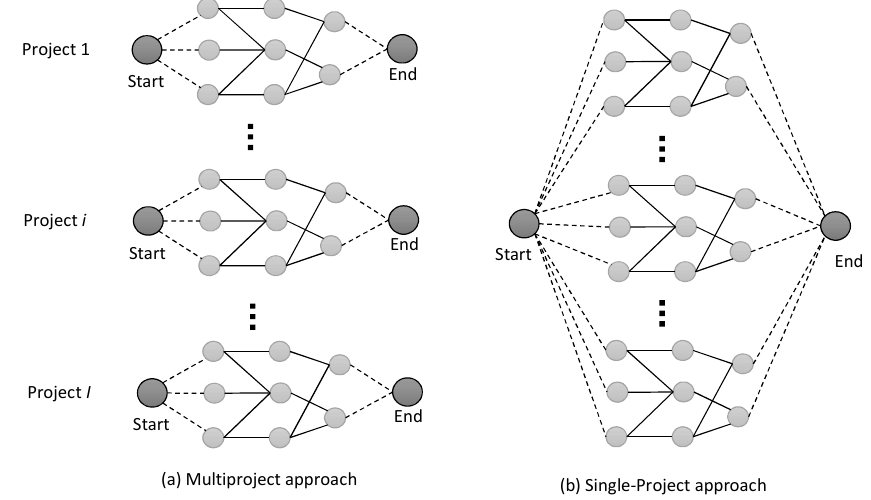
Fig. 3. The two multi-project representation’s approaches. Source: Ju and Chen,